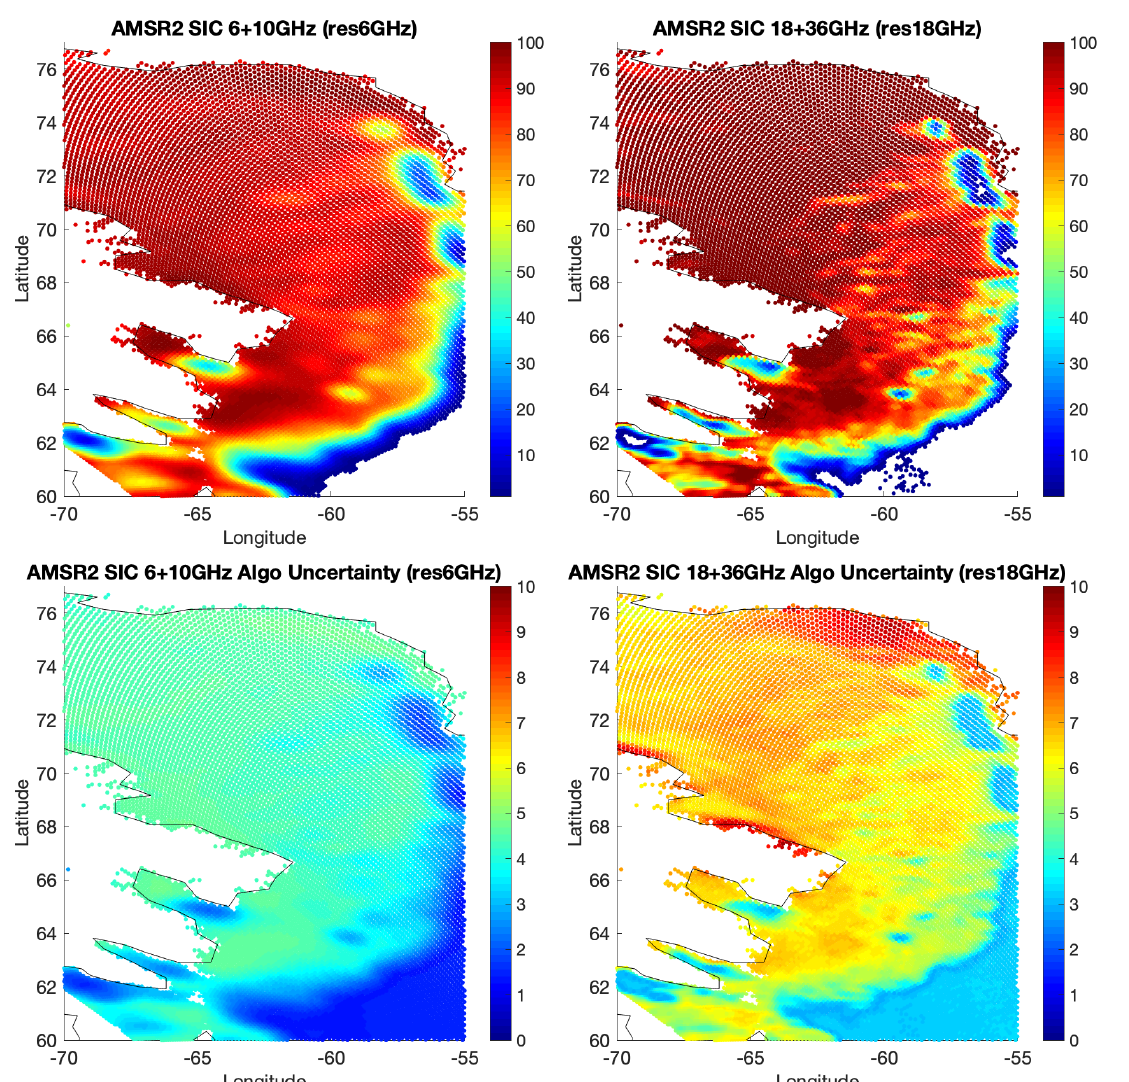
Figure 4. SIC retrieval results for the 20 April 2018 scene, along with the corresponding algorithm theoretical error std. Left: for the 6+10GHz combination (the SIC on the top and the corresponding error on the bottom). Right: same for the 18+36GHz